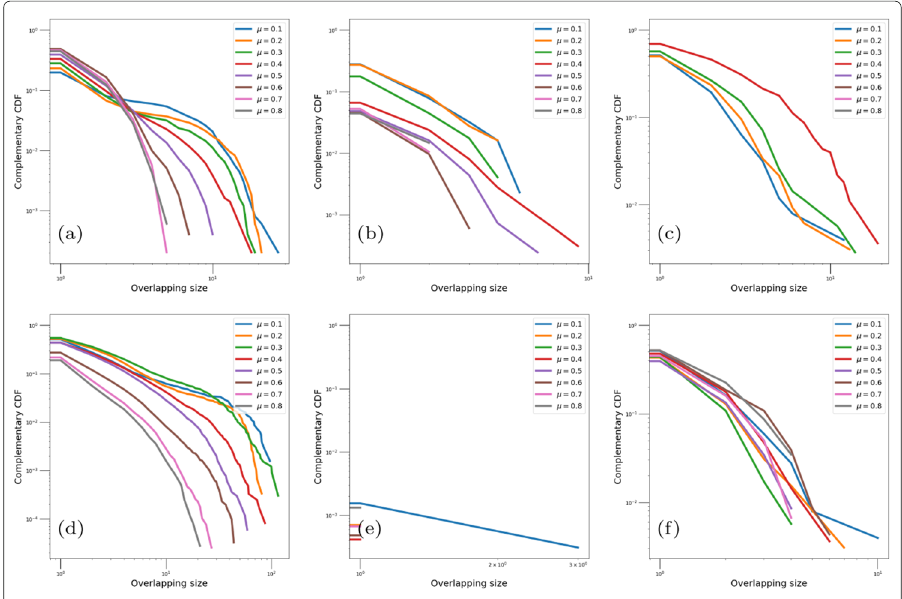
Fig. 16 Variation of the mixing parameter ( μ ) for LFR synthetic networks considering the overlapping size: a Bigclam; b CFinder; c Copra; d Demon; e SLPA; f